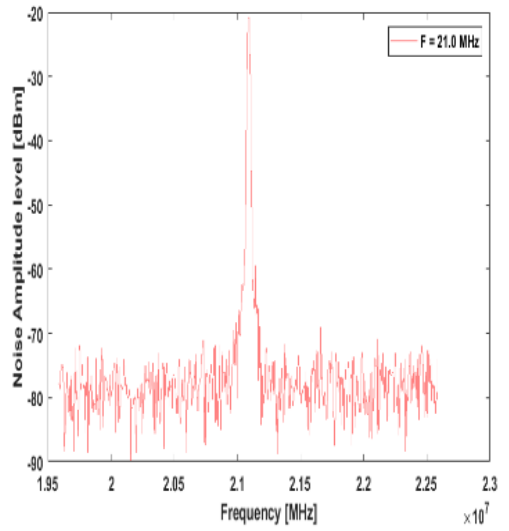
Figure 15. Waveform at 21 MHz.